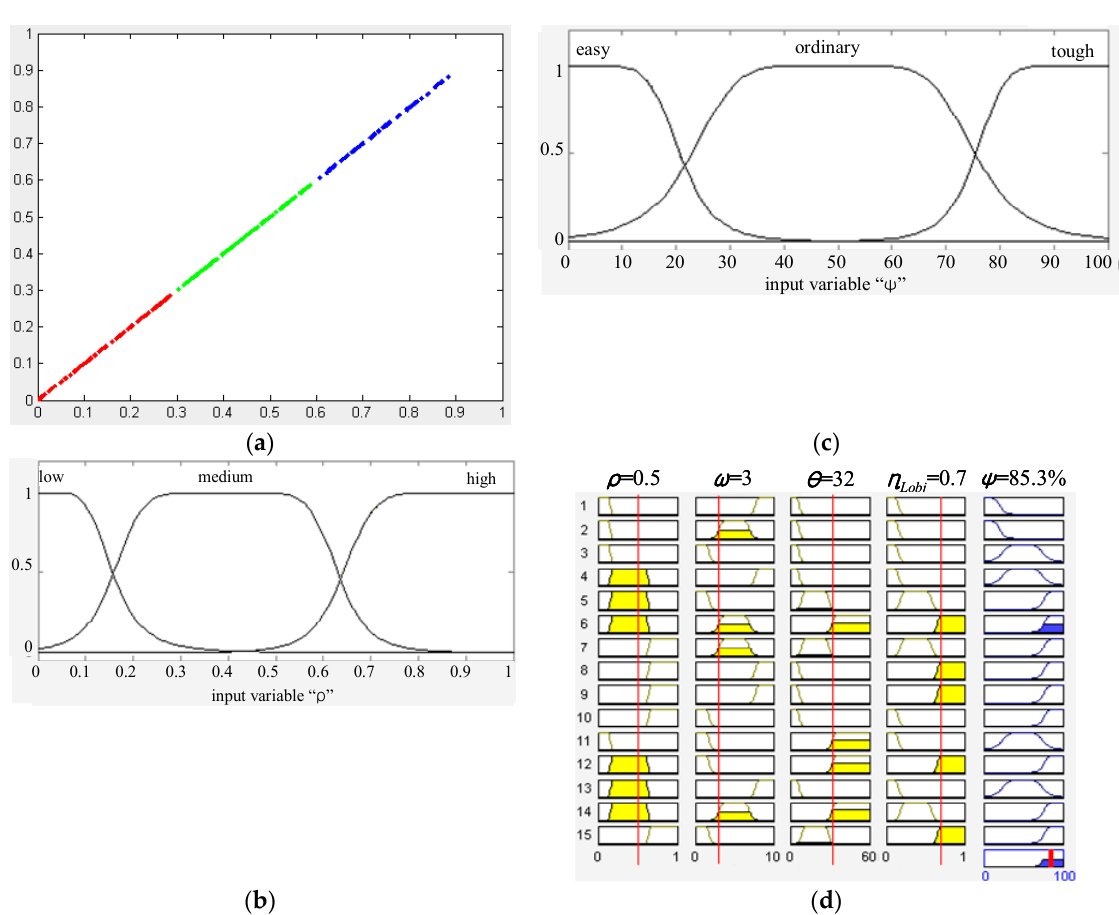
Figure 17. ( a ) Clustering of the crowdedness measurements; ( b ) Fuzzification of the crowdedness measurement ( ρ ); ( c ) Fuzzification of the road context ( ψ ); ( d ) Fuzzy logic inference of road context using evidence measurements and fuzzy rules.